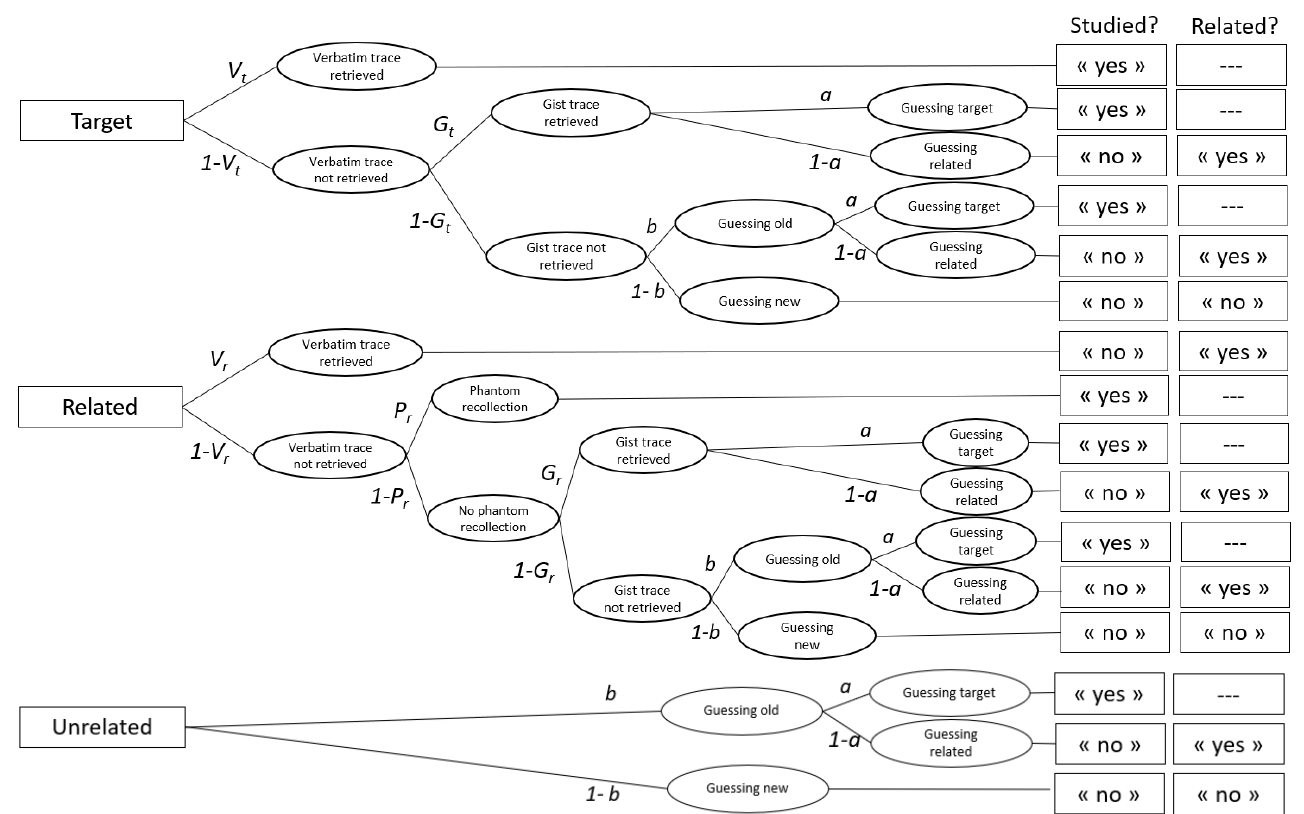
Figure 2. True and false recognition accuracy as a function of age group and attentional demand of the concurrent task. Note: We obtained the discriminability index by subtracting the proportion of false alarms to unrelated probes from the proportion of correct recognition of target probes and the proportion of false alarms to related probes. Error bars represent 95% confidence intervals for mean difference.